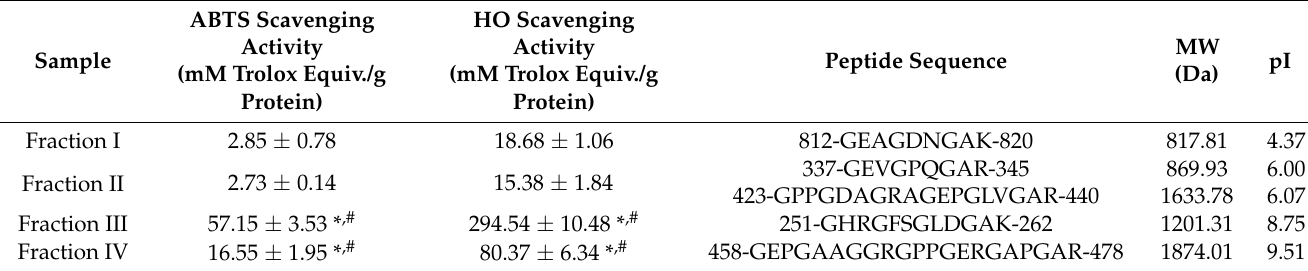
determined against ABTS and HO radicals. The sequence, molecular weight (MW) and pI of peptides identified in the